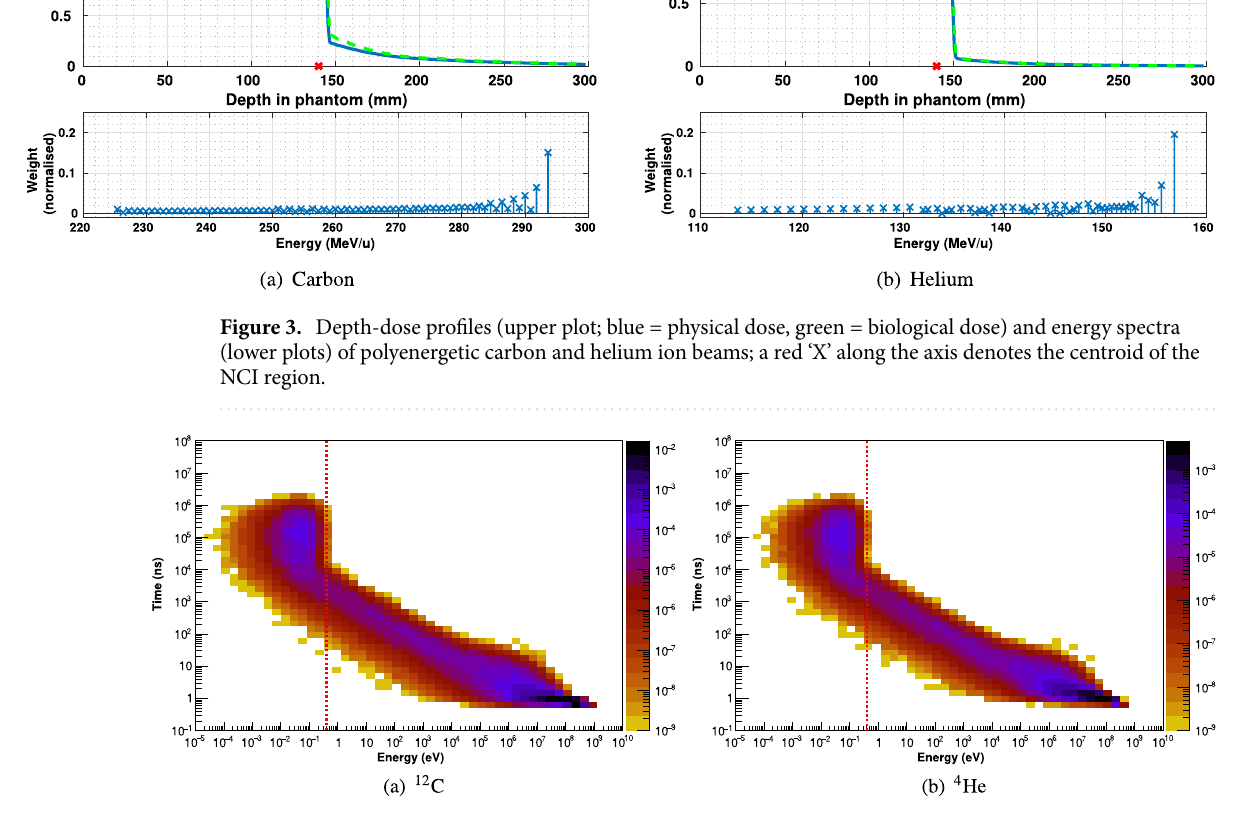
Figure 4. The arrival-time/energy spectrograms of neutrons entering the NCI region per incident particle following irradiation by polyenergetic carbon and helium ion beams. A vertical red dashed line is drawn at energy = 0.4